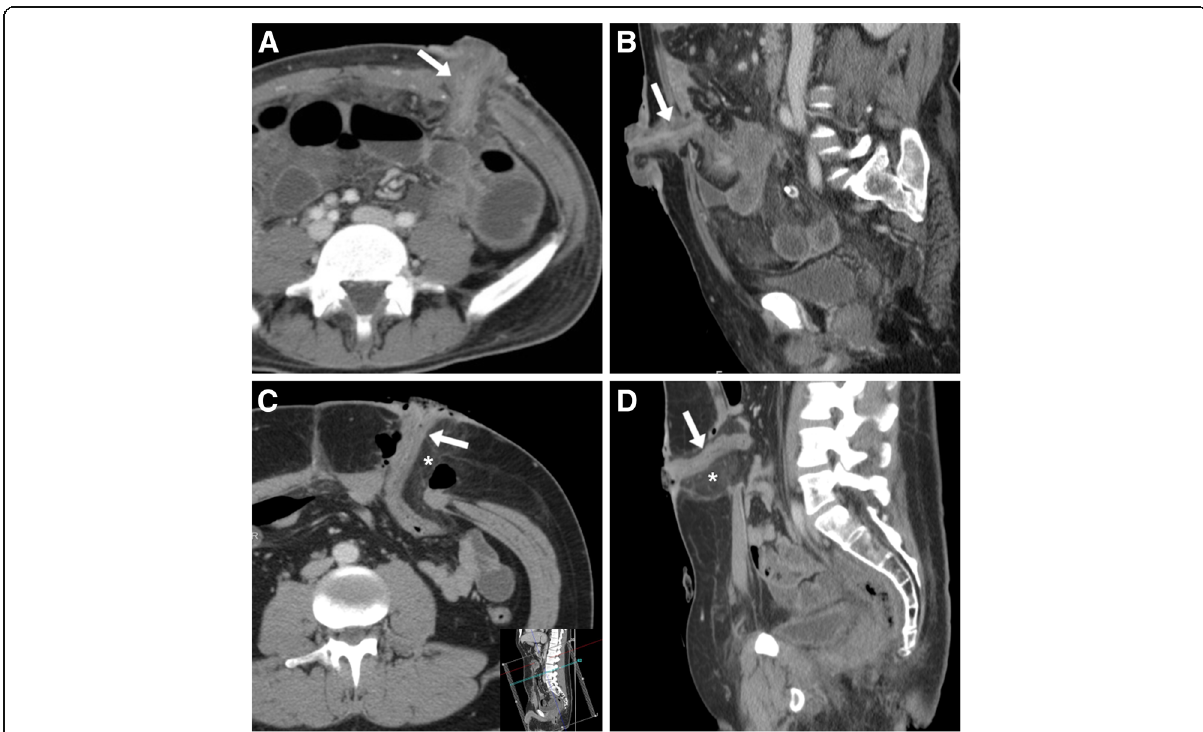
Fig. 6 Expected early CT findings in newly created stomas. a , b A typical recent ileostomy, with collapsed stomal tract (arrows) showing mild uniform mural stratification (enhancing mucosa and oedematous submucosa). c , d Uncomplicated descending colostomy created 4 days earlier during low anterior rectal resection, with stomal tract (arrows) showing similar features to a , b , surrounded by oedematous fat stranding (*) and gas bubbles as expected postsurgical